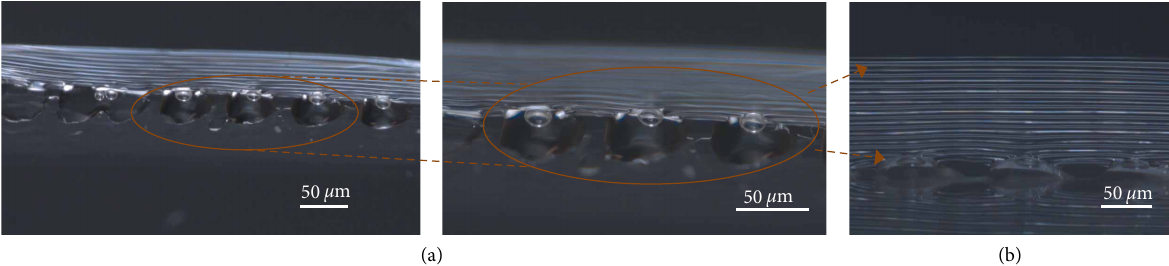
Figure 8: (a) Hybrid microstructure made of hemispherical drops and multi-layered fibers. The drops were used as pillars for the construction of a free standing wall. (b, c) Stereomicroscope image and close up of the sustaining pillars and of the overprinted